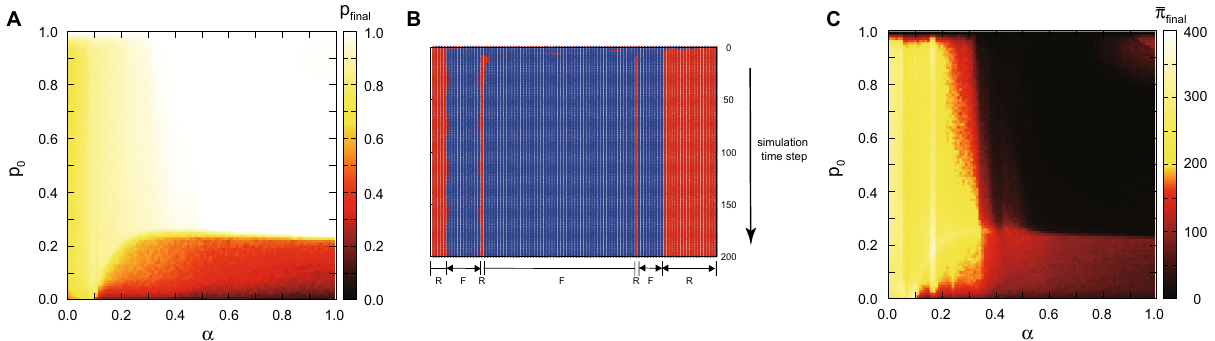
Figure 3. Results of local interaction of a network. ( A ) Simulation result of final fraction of fair players (